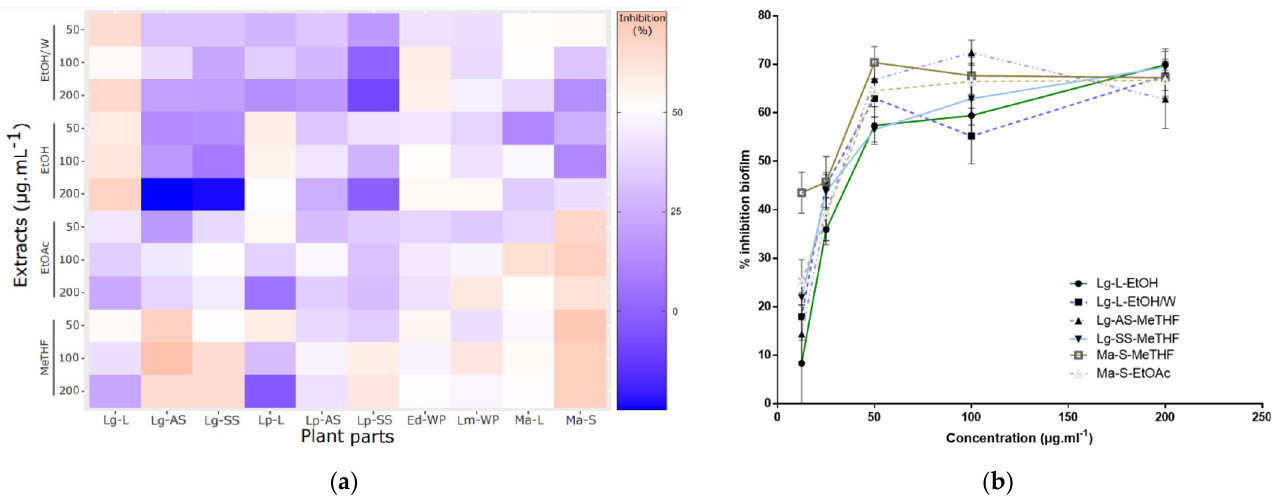
Figure 1. Plant extracts activity against S. aureus – C. albicans biofilm. Antibiofilm activities were assessed using crystal violet staining assay: ( a ) Heatmap displaying screening results of 40 plant extracts, with in ordinate the solvents of extraction and the final tested concentrations (50, 100, 200 µ g · mL − 1 ), and in abscissa the extracted plant part; ( b ) Inhibition curves of the six most active extracts (6.25 to 200 µ g · mL − 1 ), expressed in percentage of biofilm inhibition. Abbreviations: Lg ( Ludwigia grandiflora ), Lp ( Ludwigia peploides ), Ed ( Egeria densa ), Lm ( Lagarosiphon major ), Ma ( Myrio- phyllum aquaticum ), L (leaves), AS (aerial stems), SS (submerged stems with roots), S (stems), WP (whole